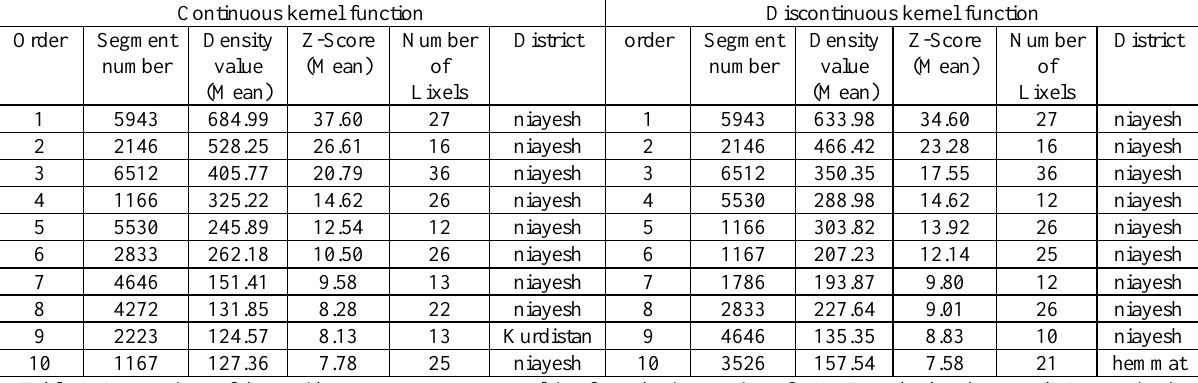
Table 2. Comparison of the accident-prone segments resulting from the integration of NKDE method and Network-Constrained Getis-Ord Gi* statistics with two different kernel functions